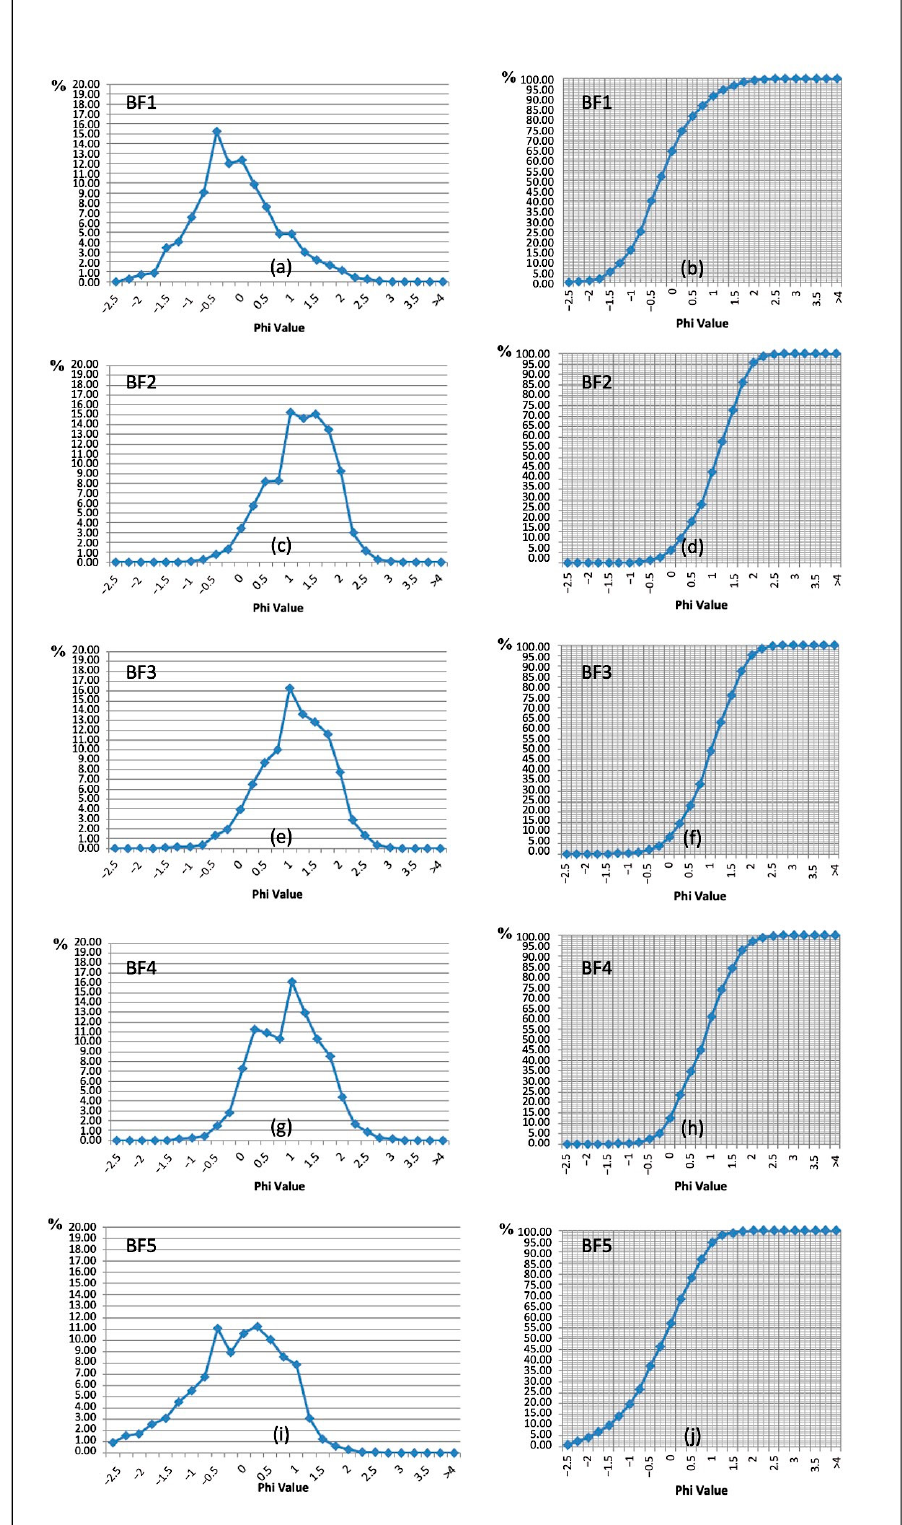
Figure 8. The Batu Ferringhi samples’ grain size distribution trend is shown in the figures labeled as ( a , c , e , g ), and ( i ). The grain sample’s cumulative frequency is shown in the figures labeled as ( b , d , f , h ), and ( j )—these five samples, BF1 to BF5, representing the original sediment accumulation along the natural coastal landform.